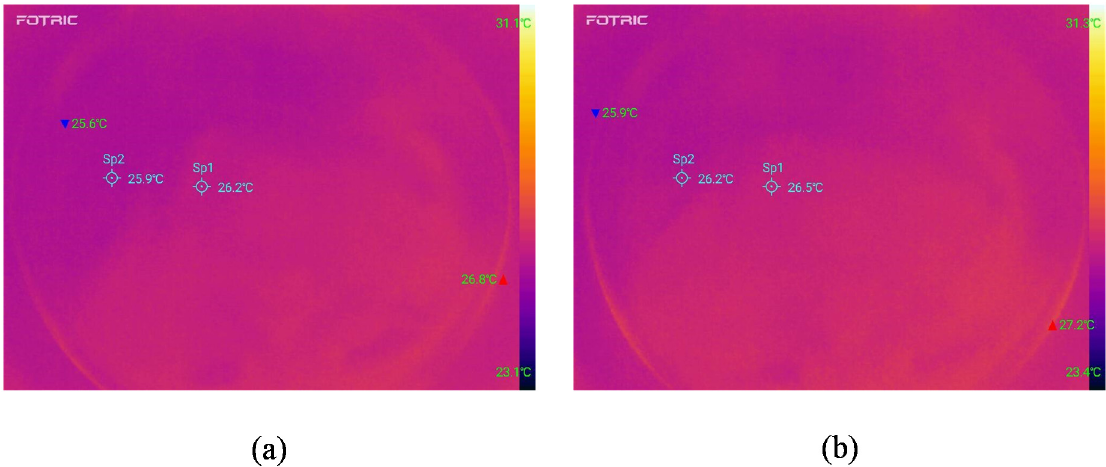
Figure 8. ( a ) Infrared thermal image of the sensor without current source. ( b ) Infrared thermal image of the sensor after working for 30 minutes under a 100 μ A constant current source.